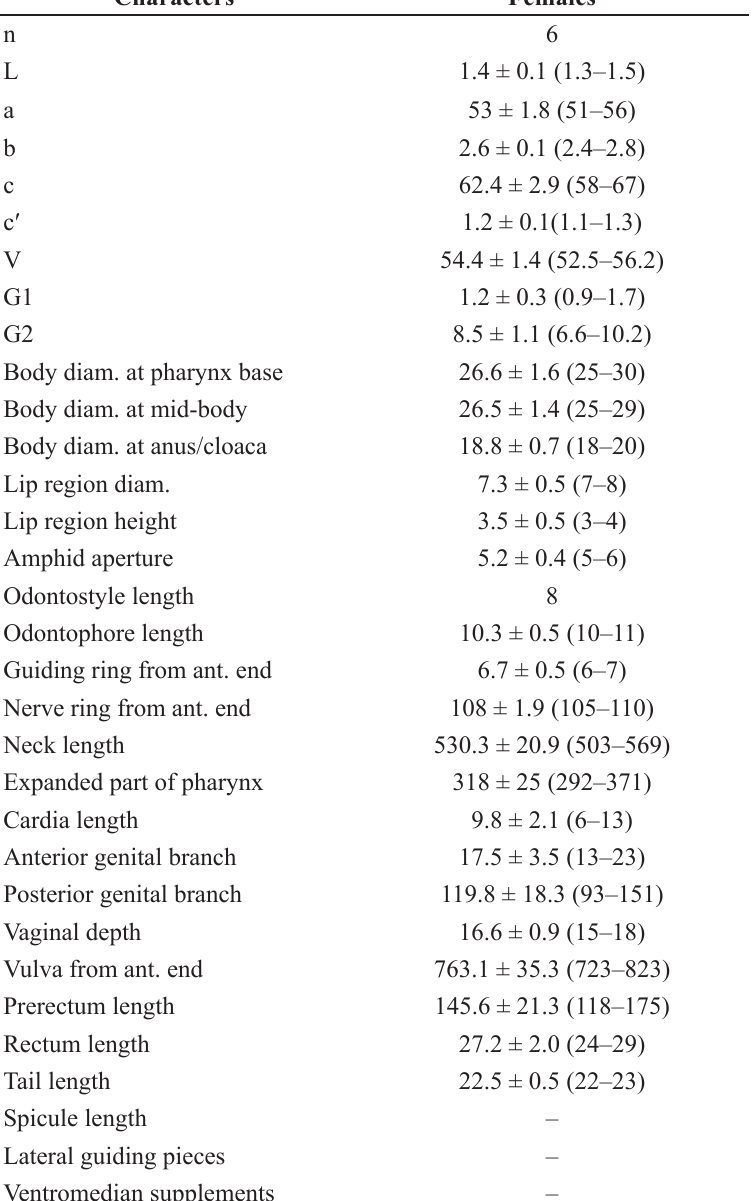
Table 1. Measurements of Axonchium nitidum Jairajpuri, 1964. All measurements in µm, except L in mm, and in the form: mean ± s.d.